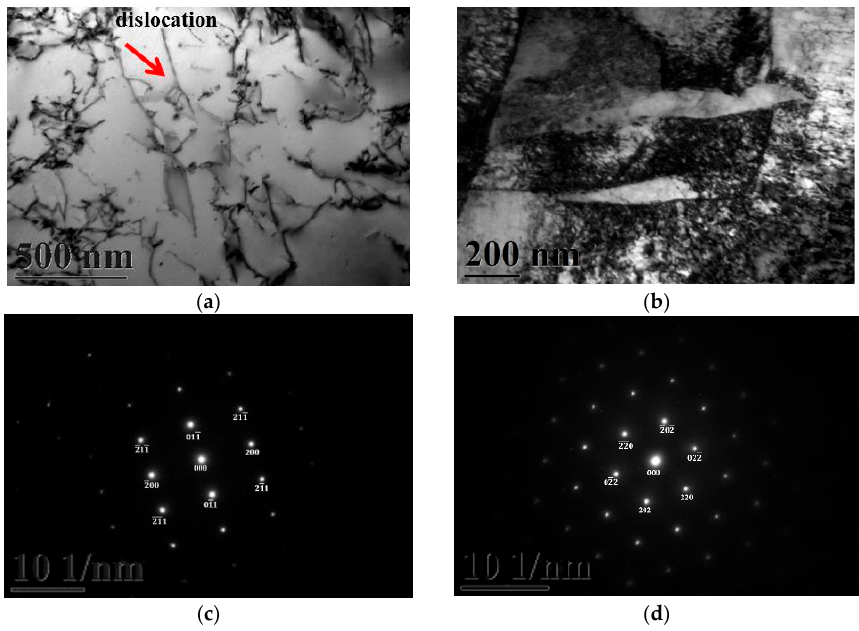
Figure 3. TEM images of the as-quenched specimen (group A). ( a ) a BF image of the ferrite matrix; ( b ) a BF image of the martensite matrix; ( c ) a SADP of the ferrite matrix, and the foil normal is g = 011; and ( d ) a SADP of the martensite matrix, and the foil normal is g = 111.